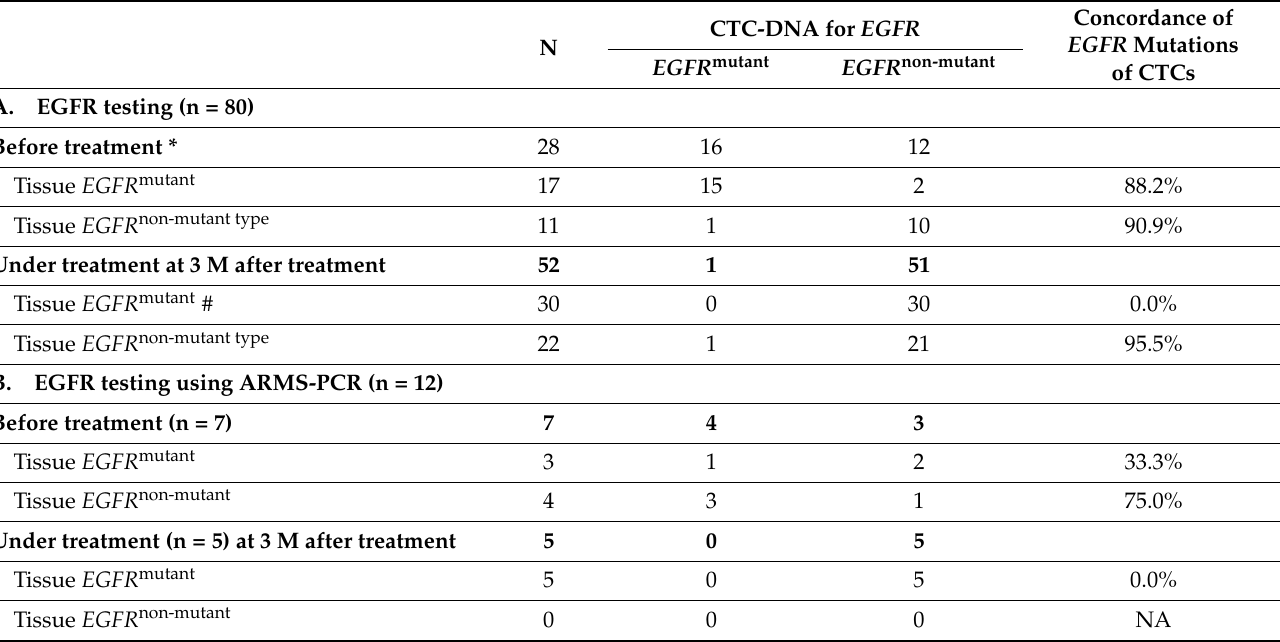
Table 2. The concordance of EGFR mutations between circulating tumor cells and cancer